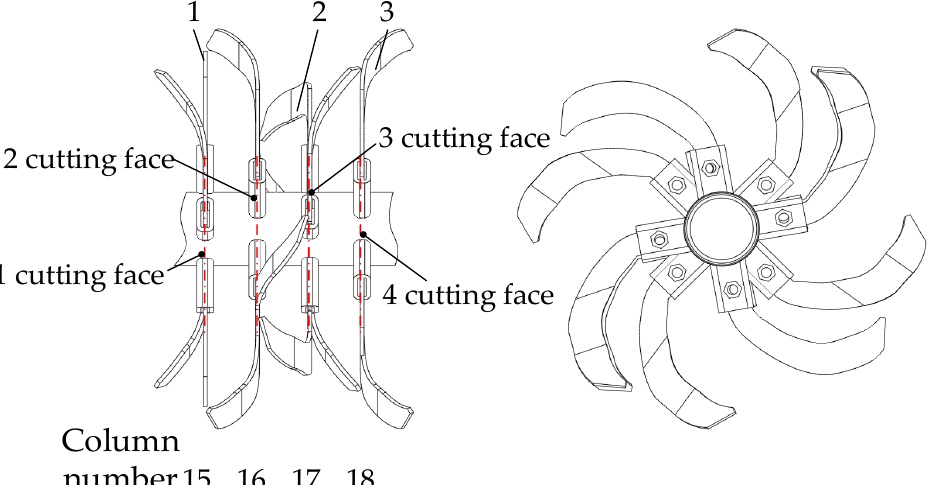
Figure 5. Structure diagrams of middle ditching section. ( 1 ) Left-curved blade; ( 2 ) Right-curved blade; ( 3 ) Straight blade.